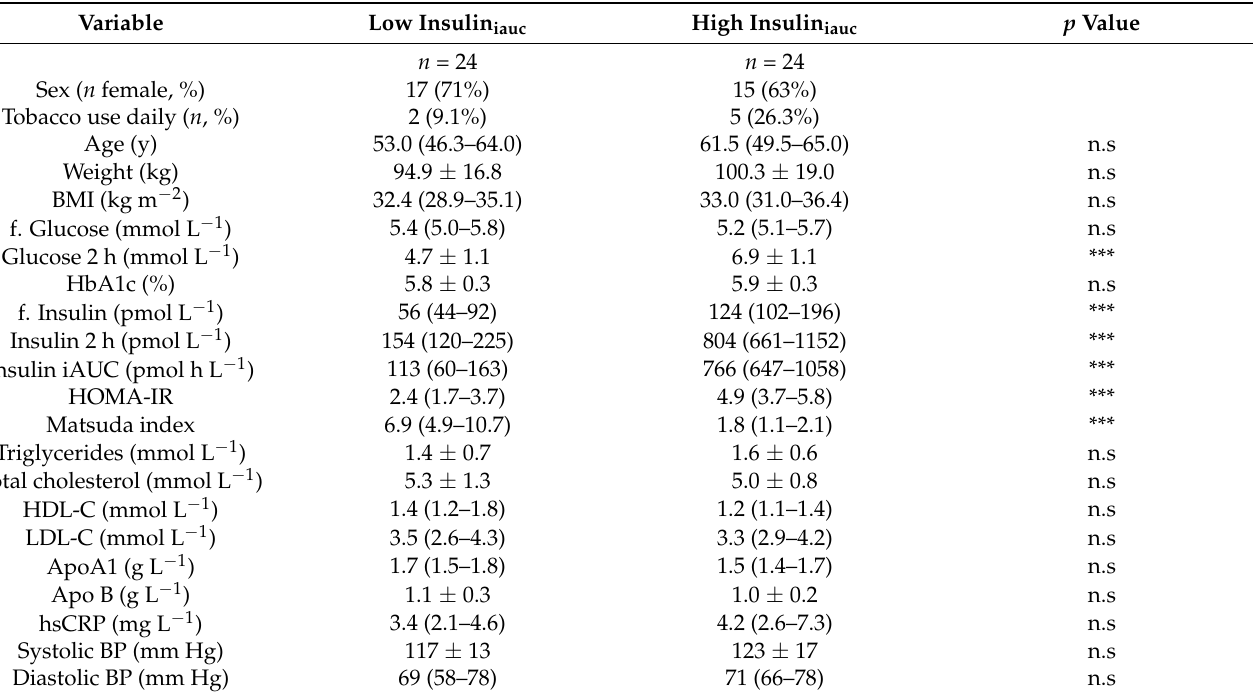
Table 1. Anthropometric and biochemical characteristics of subgroups before